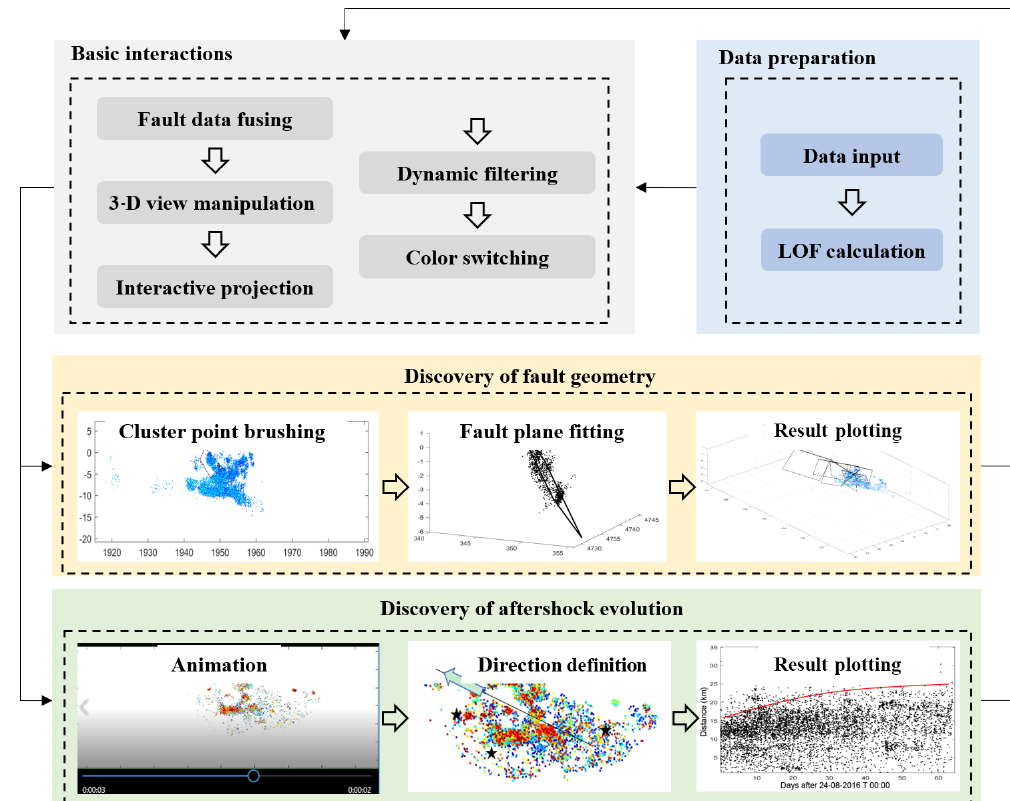
Figure 1. Flowchart of the proposed